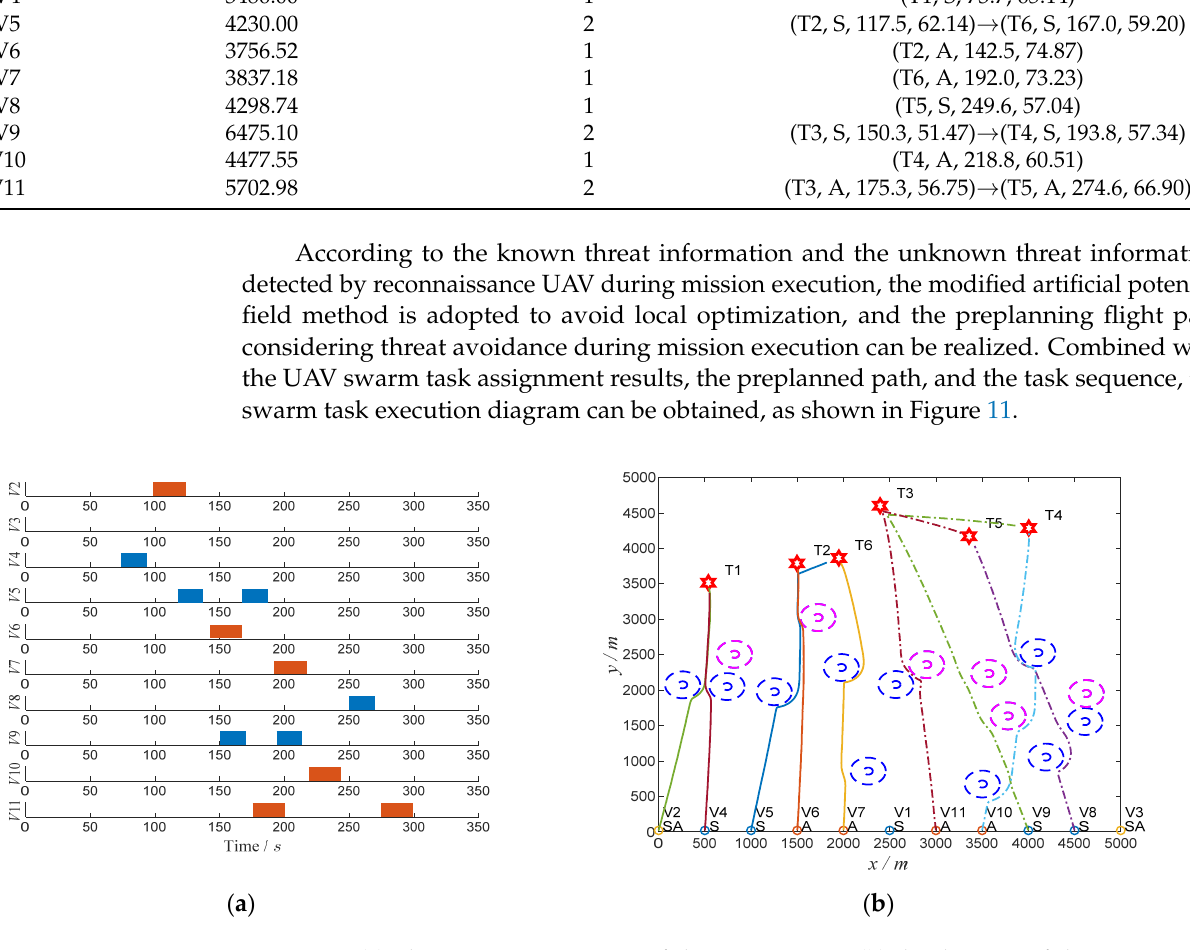
√ √ Figure 12. The initial setting of the situation between both sides. (Considering unknowned targets)